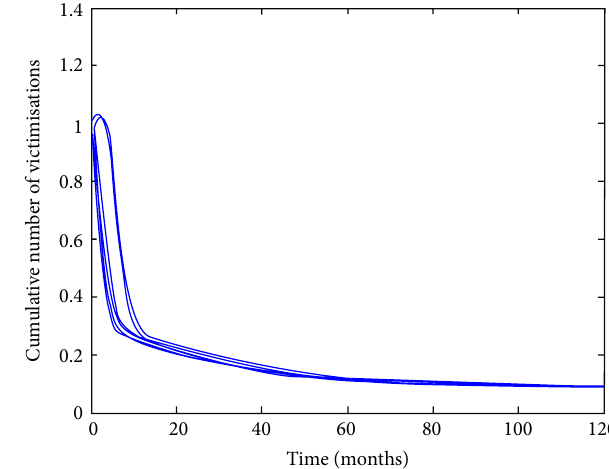
Figure 12: Simulation of model (4) using various initial conditions, showing cumulative number of victimisation cases when 𝛽 1 = 0.25 . Other parameter values used are as given in Table 3. and 𝛽 2 = 1.25